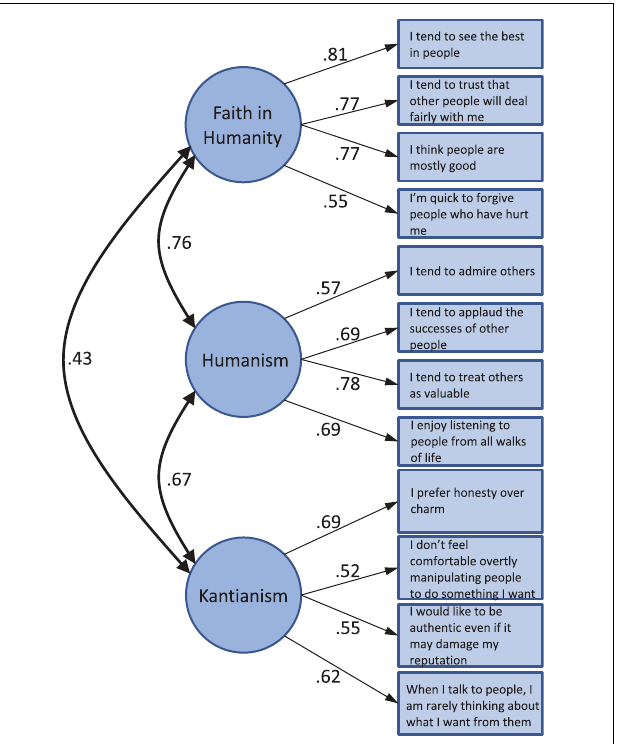
FIGURE 1 | Confirmatory factor analysis on select 12 light triad items in Study 2. n = 670.